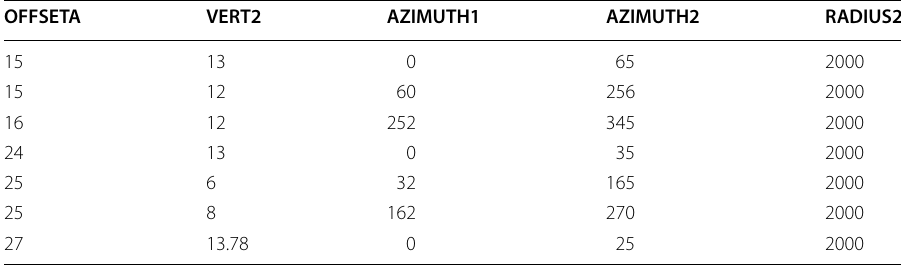
Table 4 Fields added in the base station of the visible